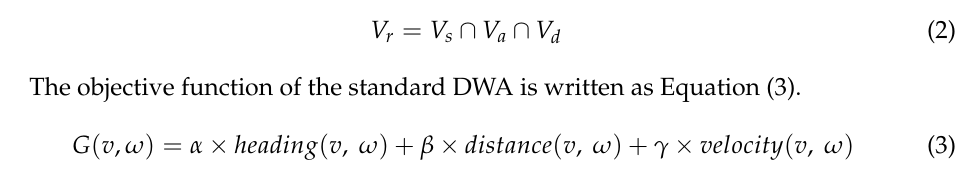
Figure 1. Dynamic window (The composition and meaning of the picture are similar to [8,9]). V r is the area excluding the area colliding with the obstacle in the V d area. This area is the input range for velocity control that allows safe movement in a range in which the vehicle can accelerate and decelerate from the current velocity [8,9].